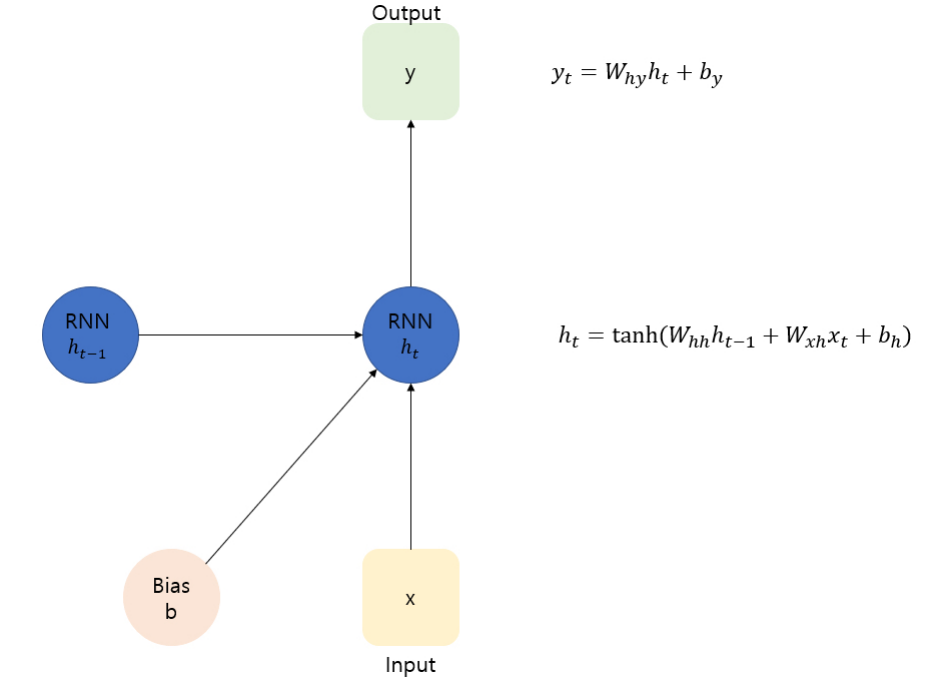
Figure 5. Recurrent neural network architecture.